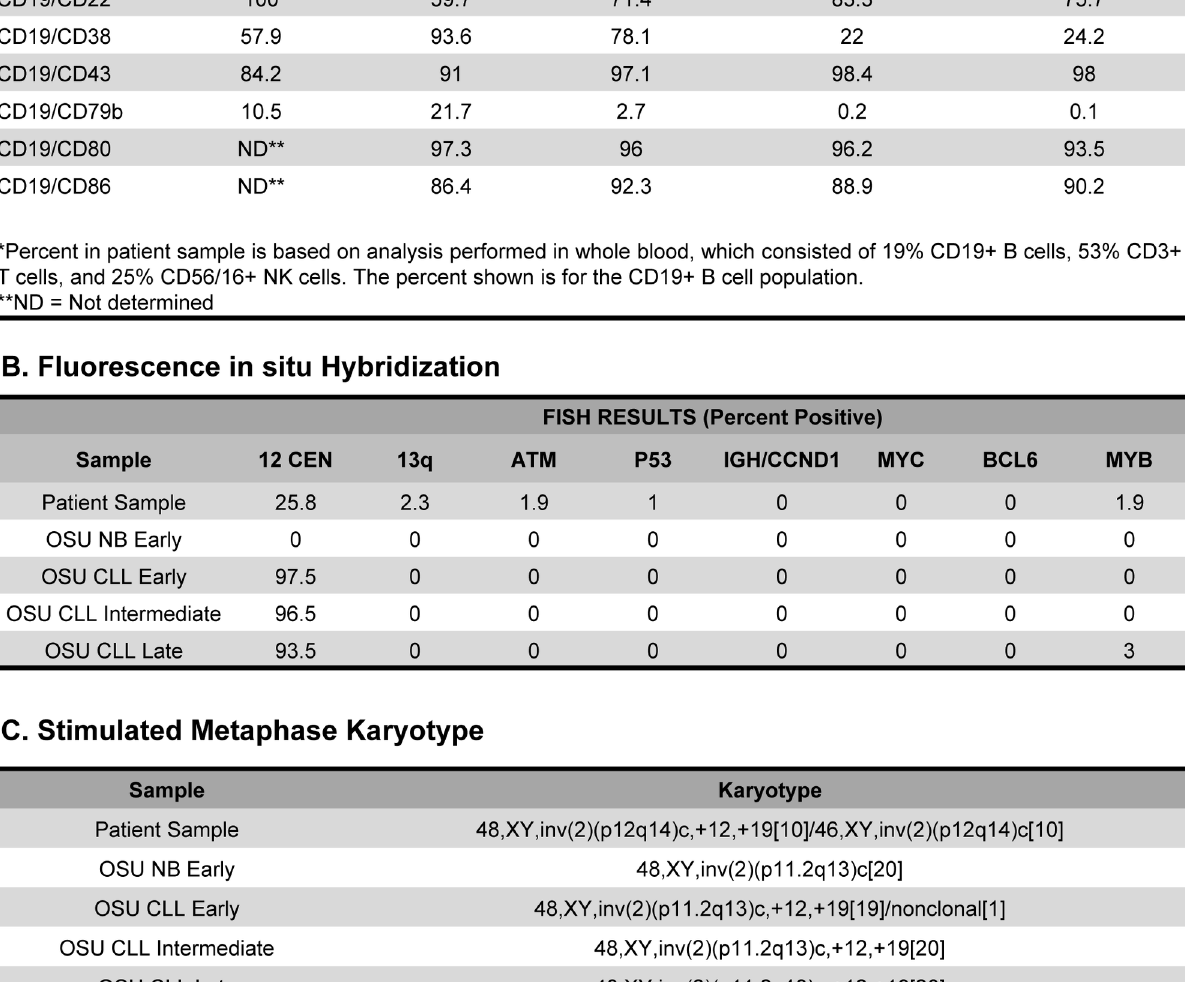
Figure 1. Molecular characterization of OSU-CLL and OSU-NB cell lines. Analysis is performed in patient sample from which the cell lines were derived as well as cultured cells from both lines (approximate timing: early = 3 months, intermediate = 6 months, late = 9 months). A . Flow cytometric analysis for CLL related surface molecules . Flow cytometric analysis for selected B-cell markers, shown as the percent of cells positive. B . Fluorescence in situ hybridization . Interphase FISH analysis for a panel of cytogenetic abnormalities associated with CLL: trisomy 12 (centromere), del(13q14) (D13S319), del(11q22.3) (ATM), del(17p13.1) (TP53), t(11;14) (CCND1-IGH fusion), +8 (MYC), +3 (BCL6), and del(6q22.3) (c-MYB). C . Karyotype analysis . Metaphase karyotype analysis to determine any additional chromosomal abnormalities not identified by FISH analysis.